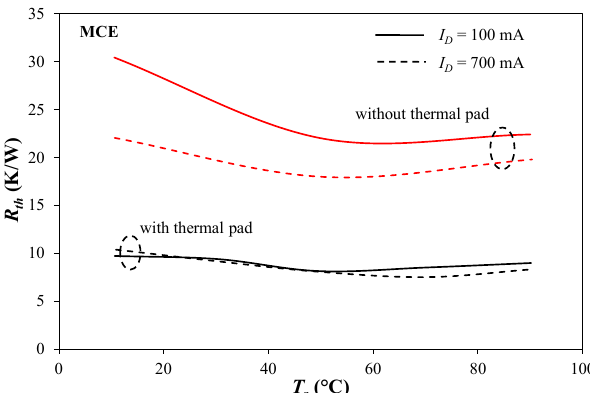
Figure 9. Measured dependences of thermal resistance of the MCE diode on the cold plate temperature for different forward current values.